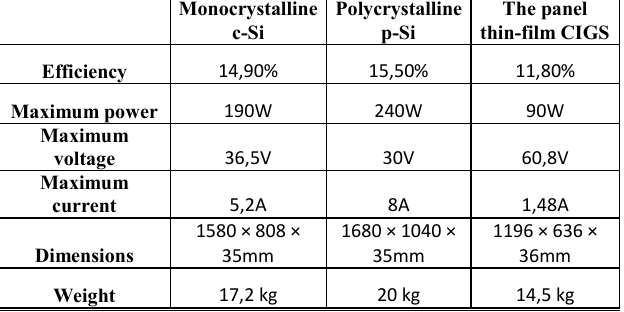
TABLE I. PV SYSTEM COMPONENTS PROPERTIES